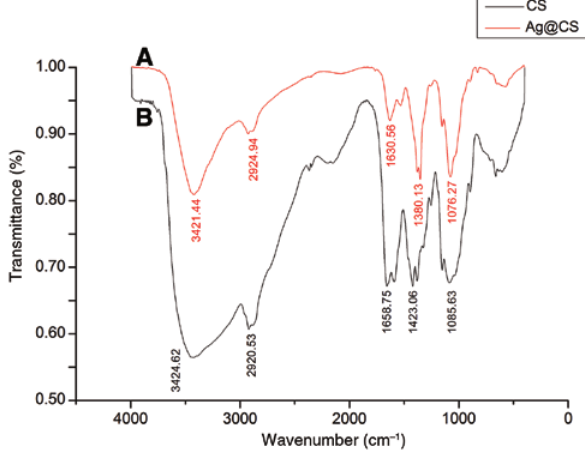
Figure 2: FT-IR spectra of Ag@CS (A) and CS